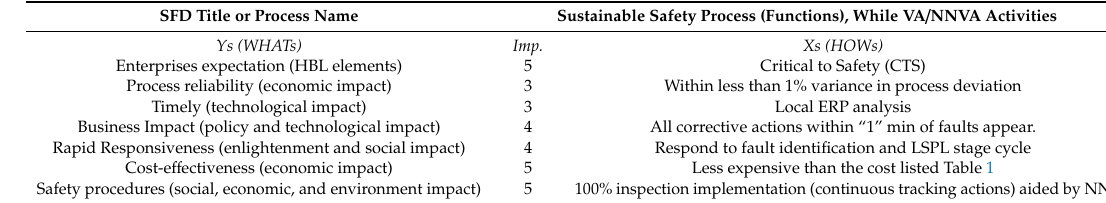
Table 4. Safety Function Deployment (SFD).